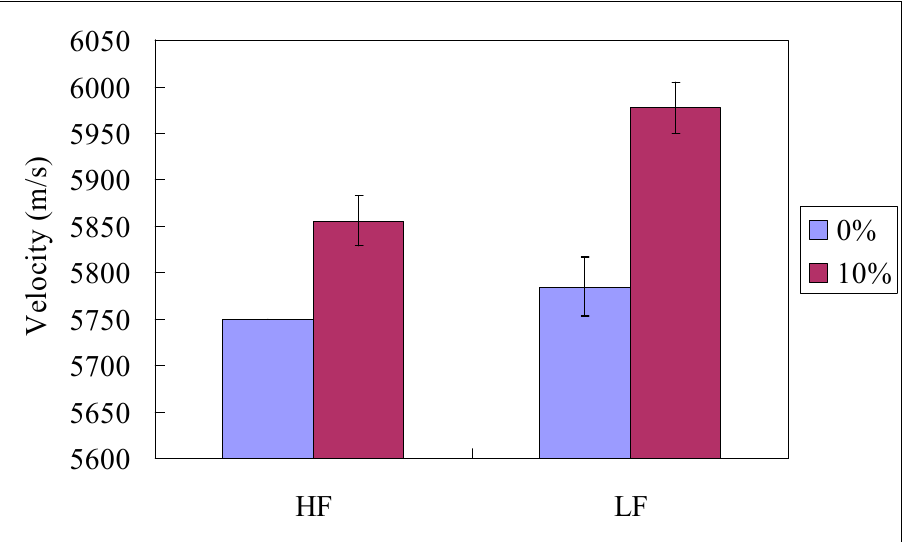
Figure 12. The ultrasonic velocity with 10% deformation for HF and LF samples.